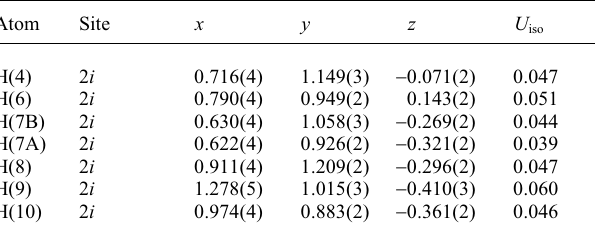
Table 2. Atomic coordinates and displacement parameters (in Å 2 )